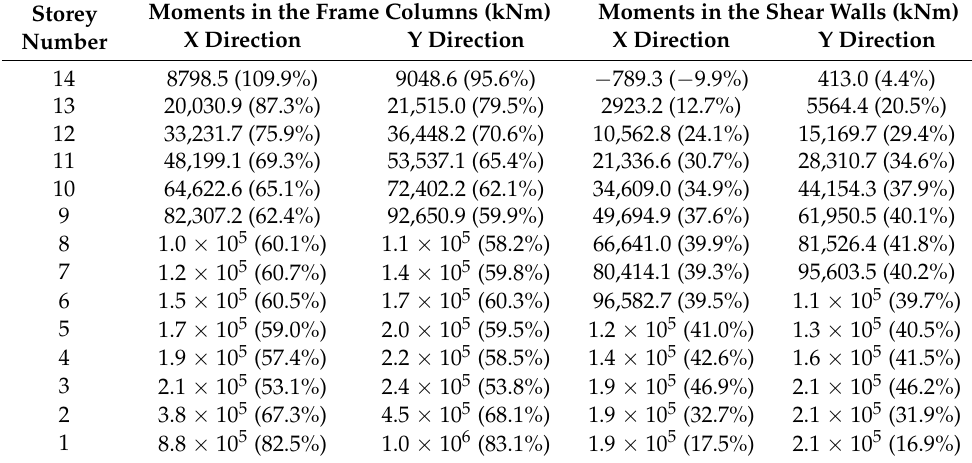
Table 8. Overturning moments of typical structural members and percentage proportions of the total overturning moments in the X and Y directions from the response spectrum